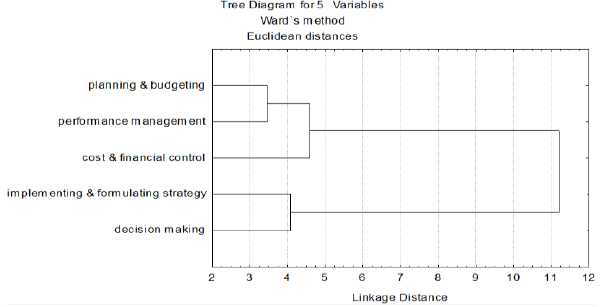
Fig. 2. The use of the information provided by the management accounting system for the performance of management activities in Romania